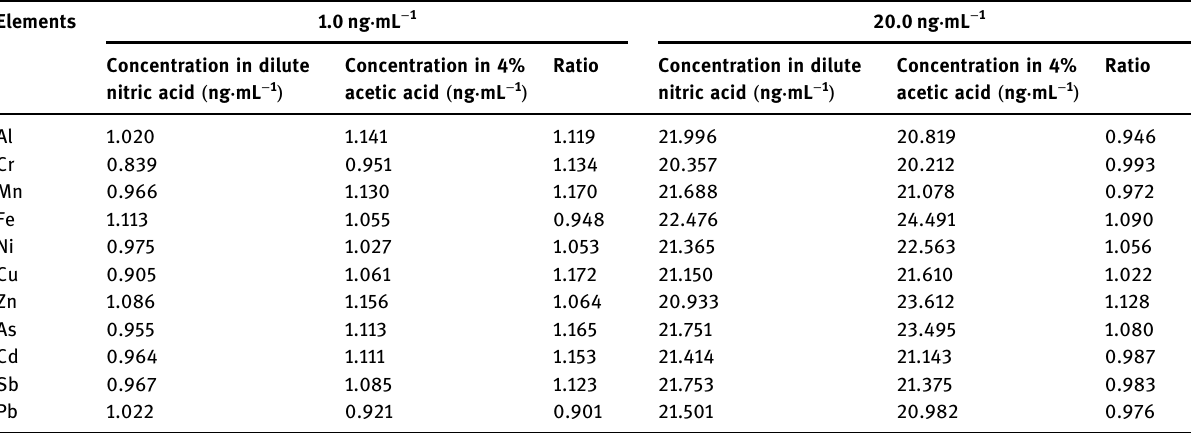
Table 3: Organic solvent interference in migration experiment